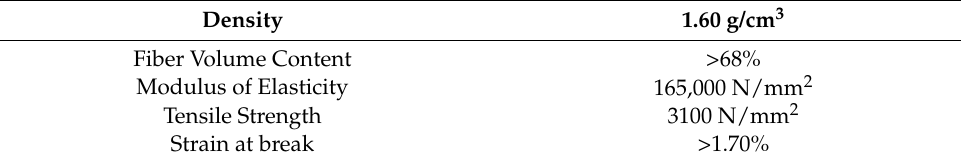
Table 1. Technical Data of CFRP.